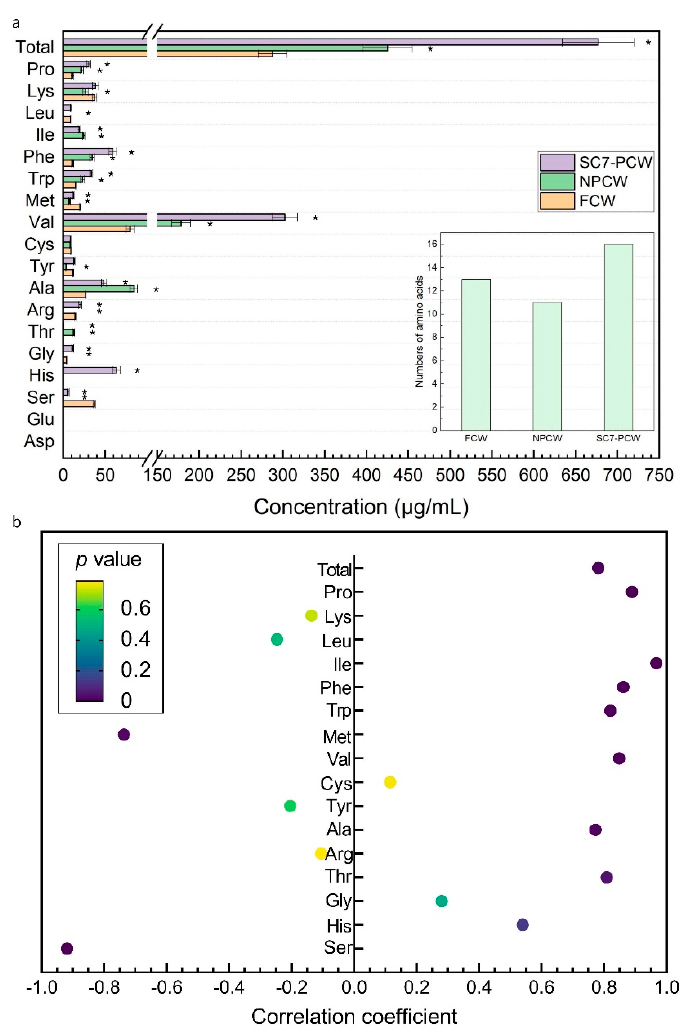
Figure 2. Amino acids in FCW, NPCW, and SC7-PCW ( a ) and Pearson’s correlation coefficient analysis between the contents of amino acids and BC yield ( b ). FCW: fresh coconut water; NPCW: natural pre-fermented coconut water; SC7-PCW: coconut water pre-fermented by S. cerevisiae SC7. Significant differences of the samples to the control group FCW were confirmed at * p < 0.05 (n = 3).